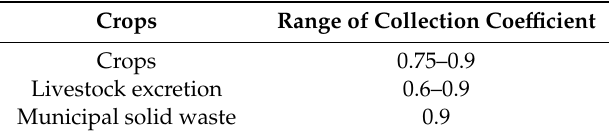
Table A4. Range of collection coe ffi cient